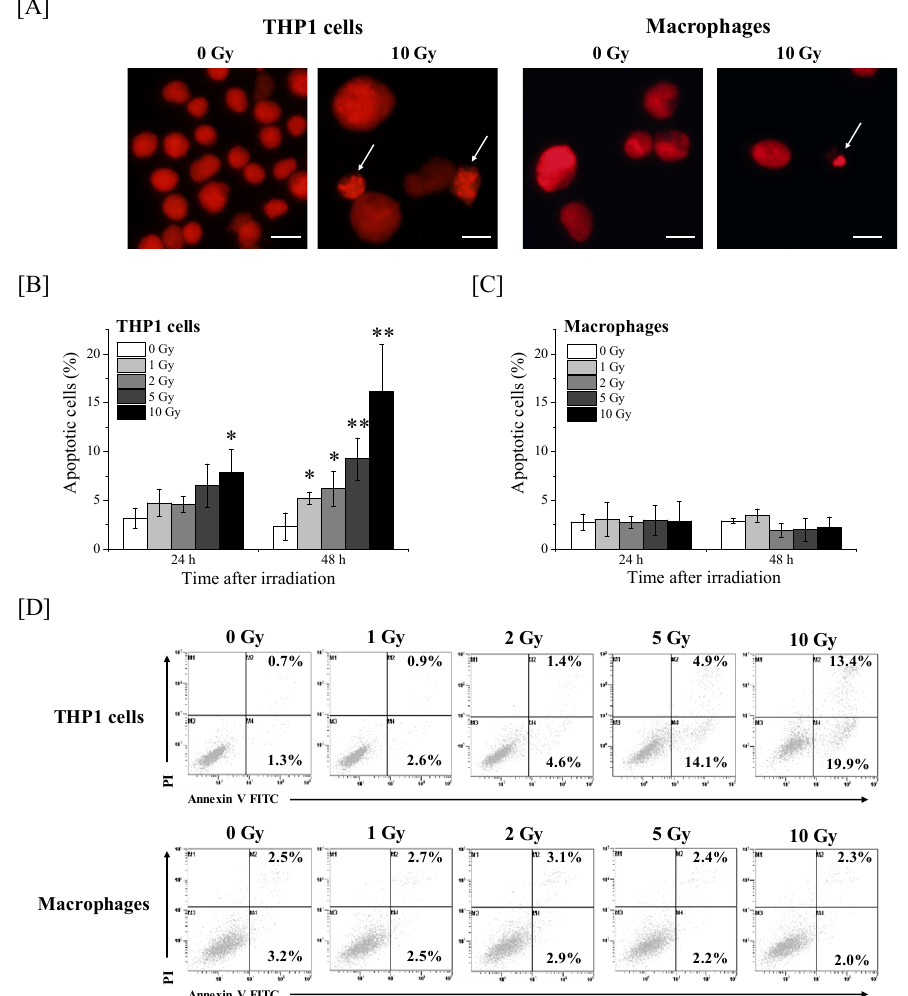
Figure 1. Effects of ionizing radiation on apoptosis induction in THP-1 cells and macrophages ( A ) THP-1 cells and macrophages irradiated with 10 Gy X-ray irradiation were cultured for 48 h and the nuclei morphology was analyzed to detect apoptosis. Representative nuclei morphologies are shown. Arrows indicate apoptotic cells. The bar in the figure is 20 µm in length. ( B , C ) THP-1 cells ( B ) and macrophages ( C ) were exposed to X-ray irradiation and then cultured for 24–48 h. After culture, the cells were harvested and evaluated for apoptosis. Data are presented as the mean ± SD of three independent experiments; * p < 0.05, ** p < 0.01. ( D ) THP-1 cells and macrophages were exposed to X-ray irradiation and then cultured for 48 h. After culture, the cells were harvested and evaluated for cell death by annexin V/PI staining. Representative cytograms are shown.